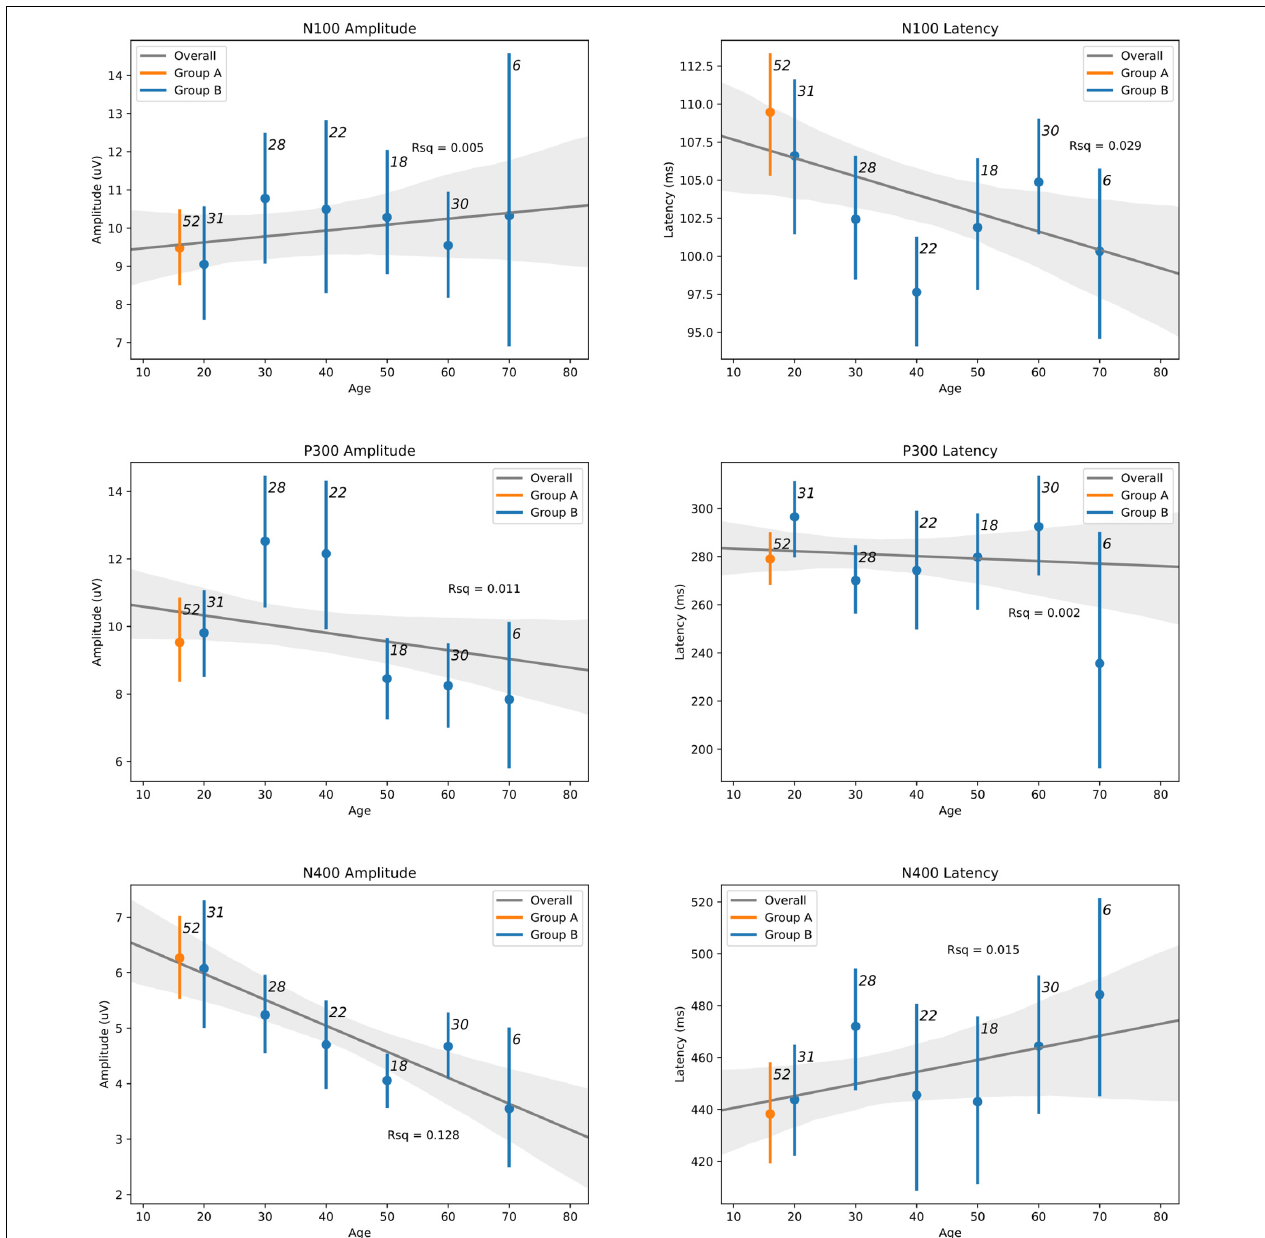
FIGURE 4 | Linear regression models with age-adjusted predictions of ERPs with 95% CIs by binned-age for elite hockey players (Group A—orange) and heterogeneous control group (Group B—blue) groups. Sample size for each bin is indicated adjacent to each CI. Best-fit line is drawn for both groups across the lifespan, with R-squared values also